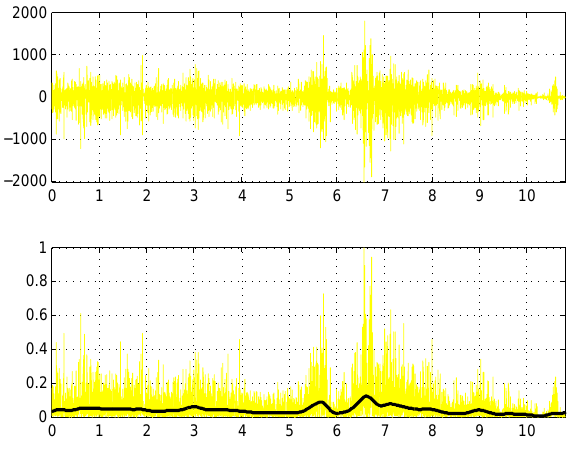
Figure 4. EMG signal pre-processing: raw signal ( Top ) and normalized rectified signal ( Bottom ) with the result of Butterworth filtering (black curve). Note: the position is in seconds on the X (horizontal)